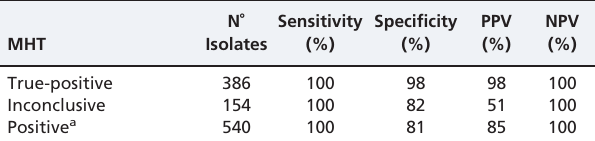
Table 2 - Performance of the modified Hodge test (MHT) for KPC